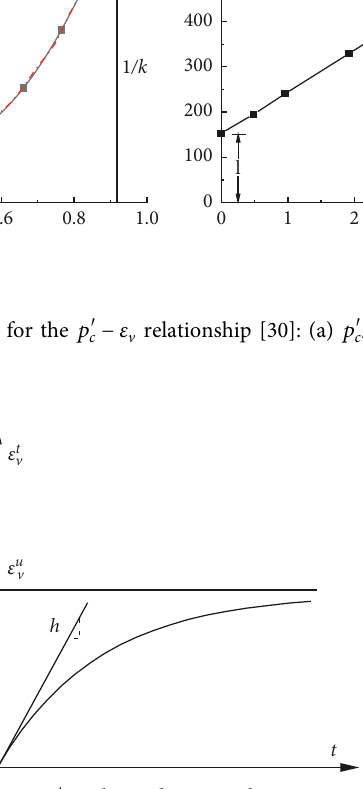
p p c ′ / a vs. ε v ; (b)